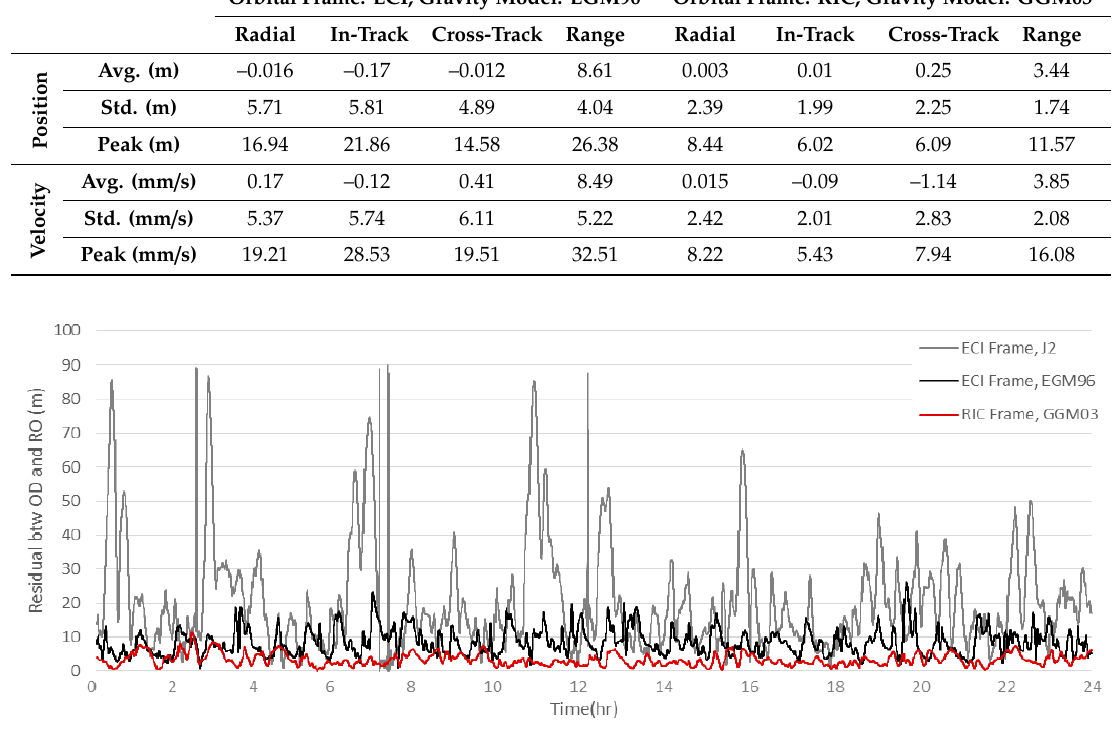
Figure 13. Advantages of applying the RIC orbital frame and GGM03 to the on-board real-time orbit determination logic of GPS-12 in DubaiSat-2. The accuracy of the determined position and velocity are improved. The peak, which might be affected by the ionospheric time delay, was also reduced successfully.